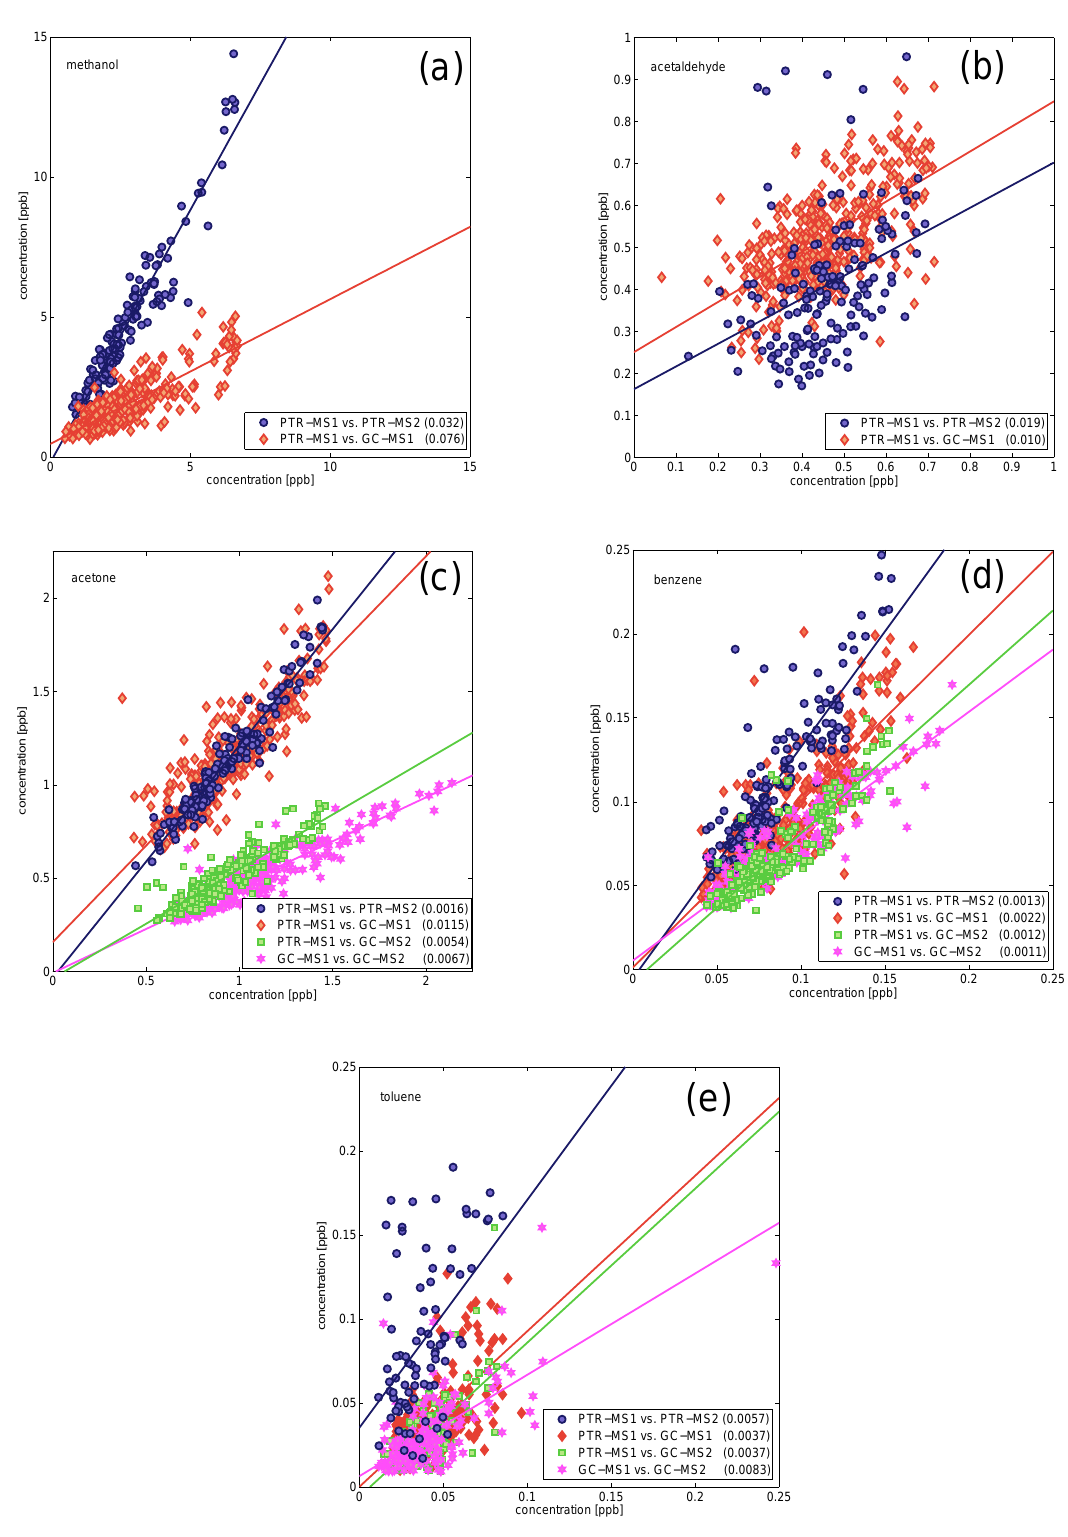
Figure 5. Comparison of volume mixing ratios of methanol, acetaldehyde, acetone, benzene and toluene measured by four different instru- ments. PTR-MS1 was compared against all three other instruments and the two GC-MSs were compared to each other. Solid lines represent linear fits and the number in brackets goodness of the fits normalized to the number of data